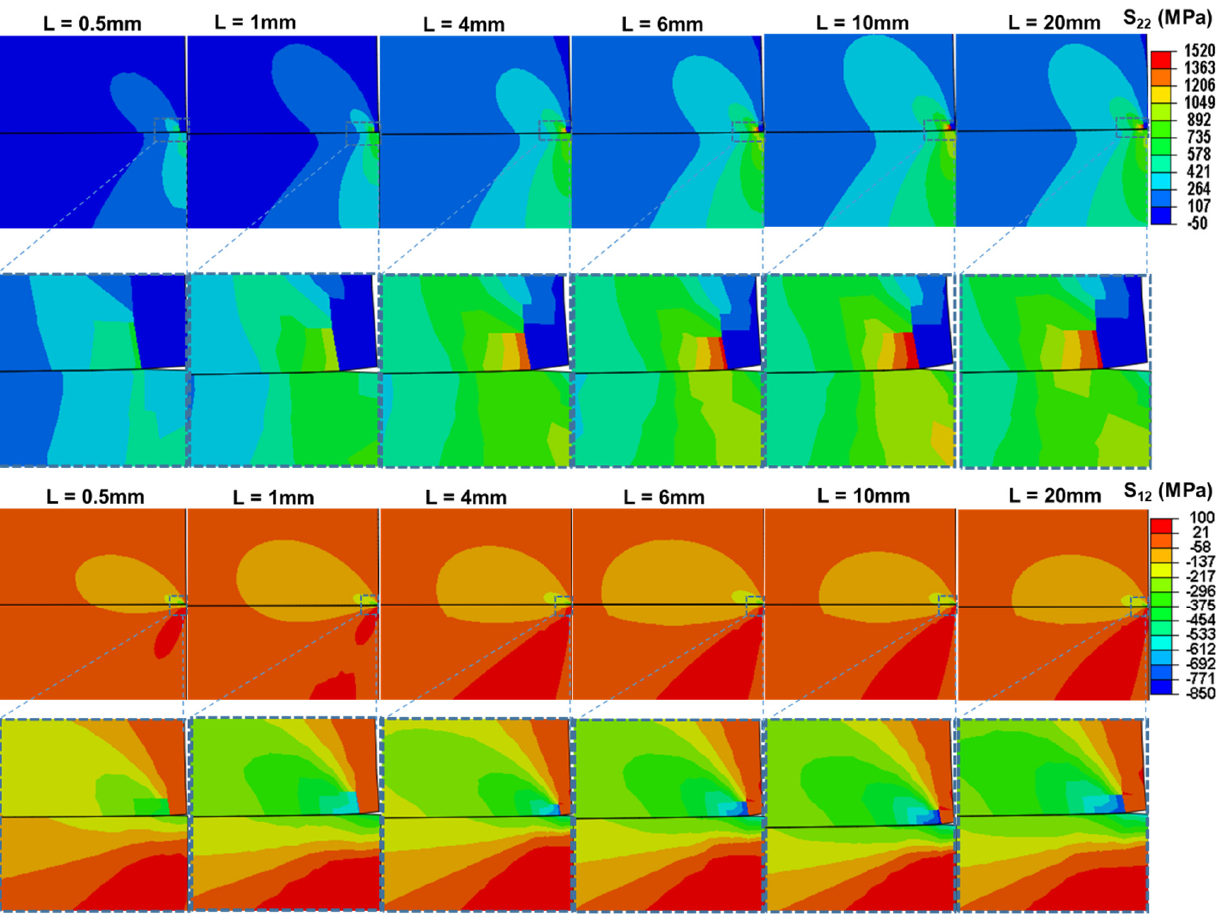
Figure 3. The stress distribution (S 22 and S 12 ) at crack tip under different SVC. Figure 4 represents the stress distribution along the path of the pre-crack for thick TBCs with different SVC. The horizontal line is shown in Figure 3, representing the path along which the pre-crack is propagated. In Figure 4a,b, the jump phenomenon of stresses ( σ 22 and σ 12 ) at the pre-crack tip has appeared. The stresses ( σ 22 & σ 12 ) at the position away from the pre-crack tip have a lower value. The value of stresses at the pre-crack tip is at minimum ( σ 22 = 410 MPa and σ 12 = 278 MPa) when the SVC is minimum ( L = 0.5 mm). The jump phenomenon of stresses at the pre-crack tip is increased with an increase in the SVC, and its value is at maximum σ 22 = 999 MPa and σ 12 = 542 MPa when “ L ” is 10 mm. It indicates that a larger SVC refers to smaller strain tolerance. This is why the thermal shock resistance of TBCs is weak for conventional coating structures without vertical cracks. It implies that the crack expands easily with a higher SVC in ceramic